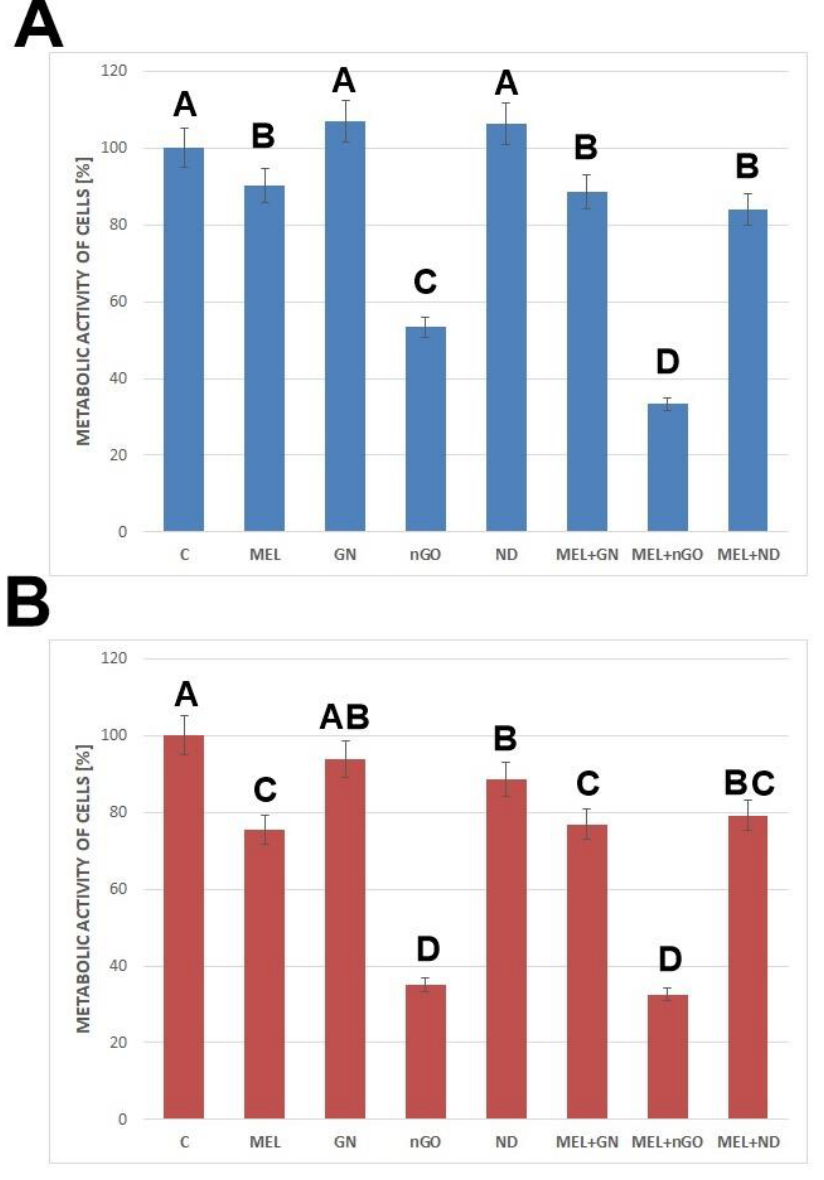
Figure 5. The viability of cells after treatment with melittin complexes with nanoparticles, melittin, and nanoparticles alone. ( A )— results for MCF-7 cell line, ( B )—results for MDA-MB-231 cell line; C—control group; MEL—group treated with melittin at a concentration of 10 mg / L; GN—group treated with natural graphene (20 mg / L); nGO—group treated with graphene nanoxide (20 mg / L); ND—group treated with nanodiamond (20 mg / L); GN + MEL—group treated with melittin complex (10 mg / L) and natural graphene (20 mg / L); nGO + MEL—group treated with melittin complex (10 mg / L) and graphene nanoxide (20 mg / L); ND + MEL—group treated with melittin complex (10 mg / L) and nanodiamond (20 mg / L). A, B, C, D—results in one group with di ff erent indexes are significantly di ff erent ( p -value <